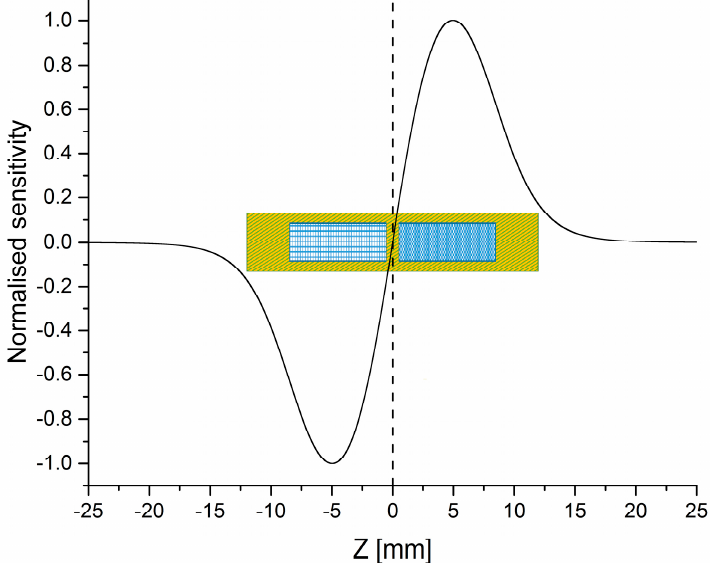
Figure 3. Simulated normalized sensitivity profile of the measurement head shown in Figure 2. Additionally the Z-positions of the differential detection coil with its two compartments for measurement (fine blue grid, right) and reference (blue grid, left) as well as the excitation coils (HF + LF, green-yellow, diagonal lines) are indicated.